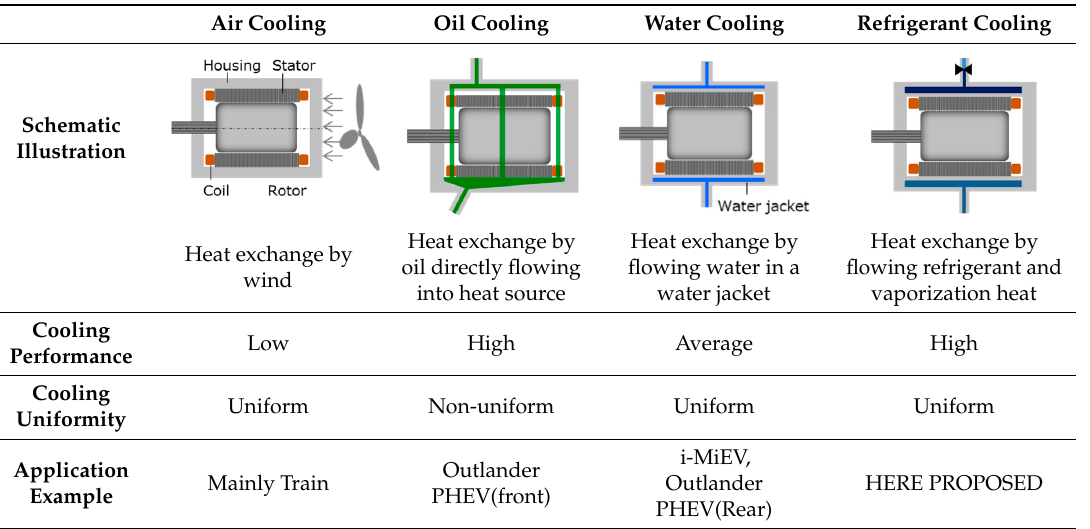
Table 1. Motor cooling methods.